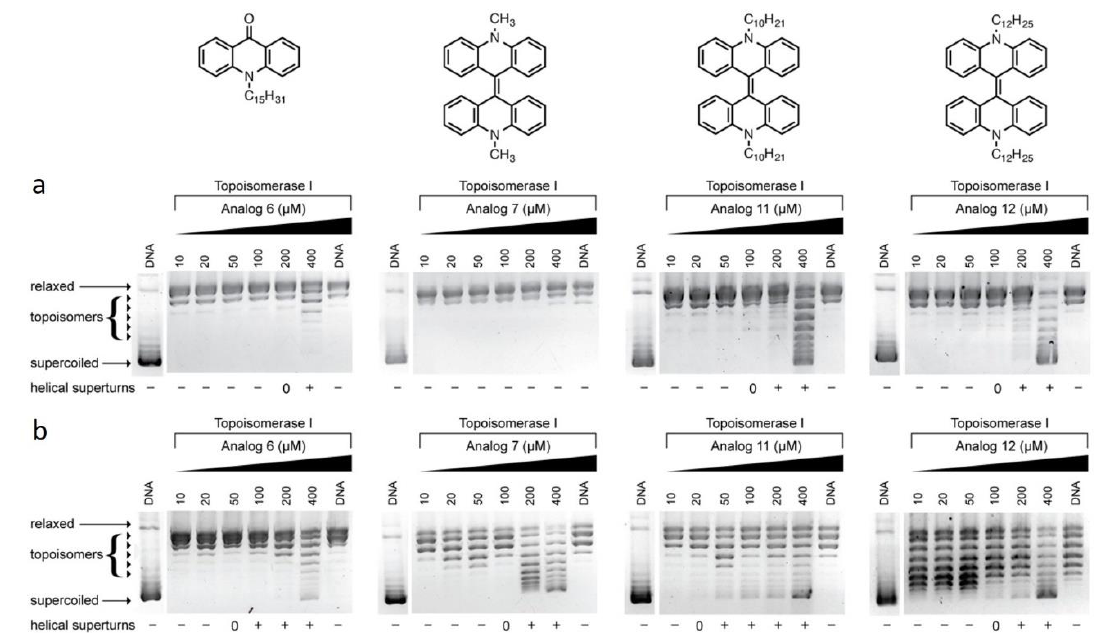
Figure 2. Topoisomerase-I mediated DNA relaxation assay in the presence of increasing concentrations (10–400 µ M) of N -alkylacridone 6 and N , N (cid:48) -dialkyl-9,9 (cid:48) -biacridylidenes 7, 11, and 12 at pH 7.2 ( a ) and pH 5.8 ( b ),